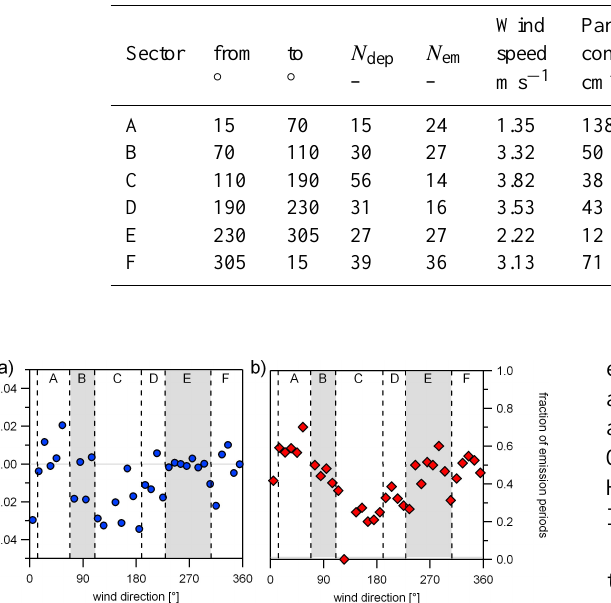
Fig. 4. (a) Median aerosol number fluxes in 10 ◦ wind direction bins. (b) Time fraction of emission episodes averaged over 30 ◦ wind bins and plotted every 10 ◦ . Grey shading indicates the transi- tional wind sectors B and